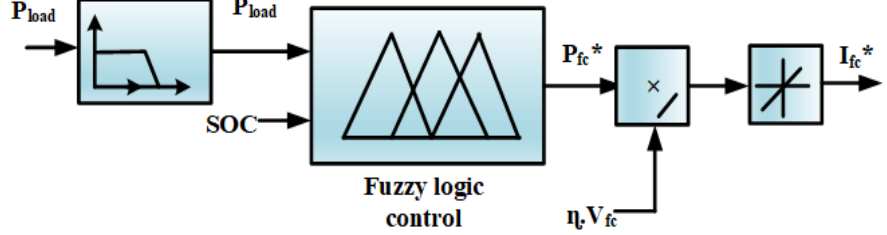
Figure 4. State machine control hysteresis.